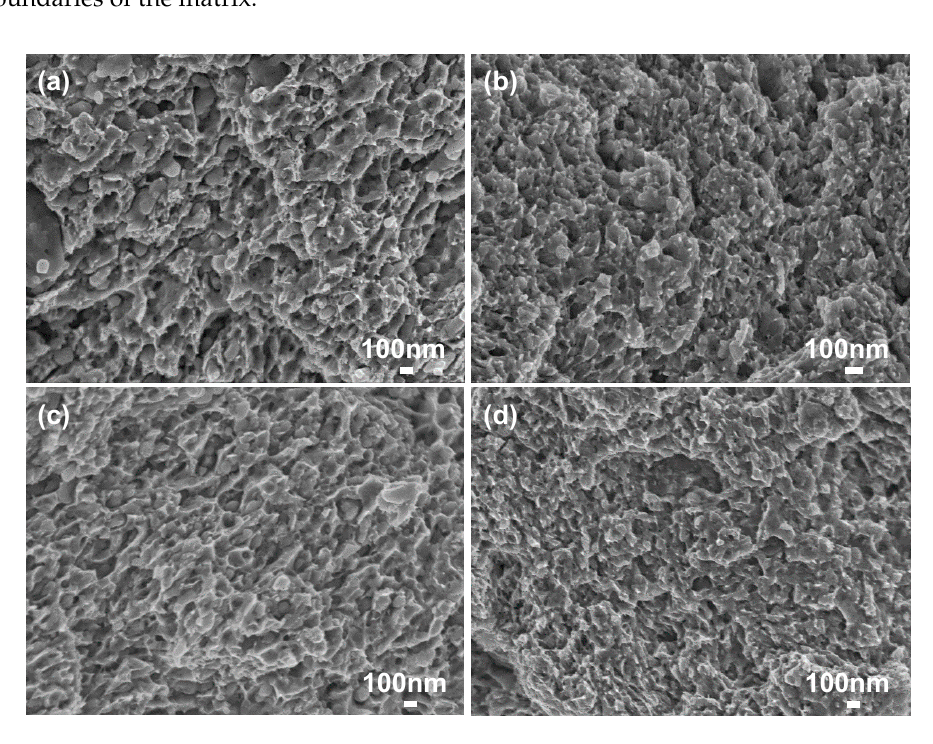
Figure 7. Fracture surfaces of 10 vol. %TiC ( a ) Cu–TiH2–C nanocomposite sintered at 900 ◦ C; ( b ) Cu–Ti–C nanocomposite sintered at 900 ◦ C; ( c ) Cu–TiH2–C nanocomposite sintered at 1000 ◦ C; and ( d ) Cu–Ti–C nanocomposite sintered at 1000 ◦